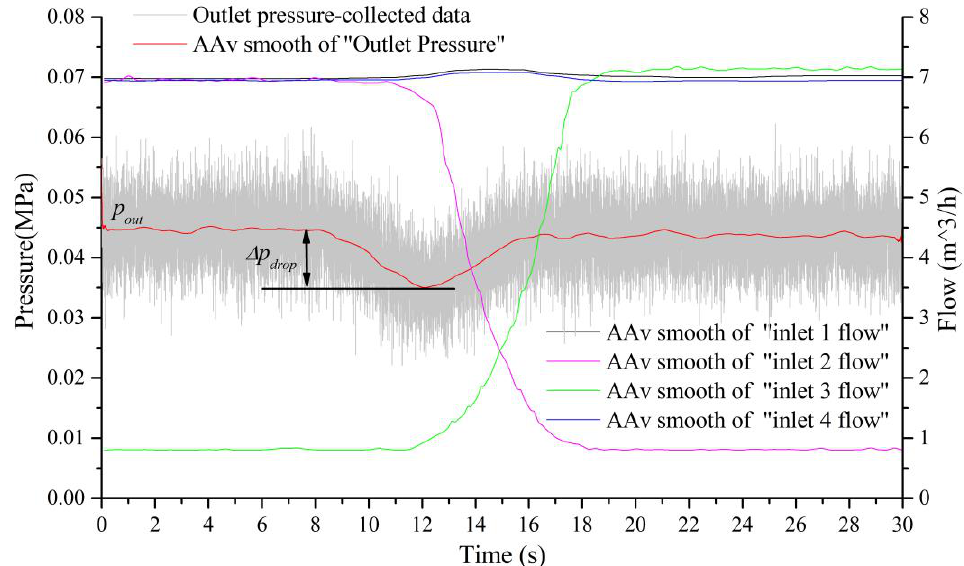
Figure 3. Measurement data for a typical operation.